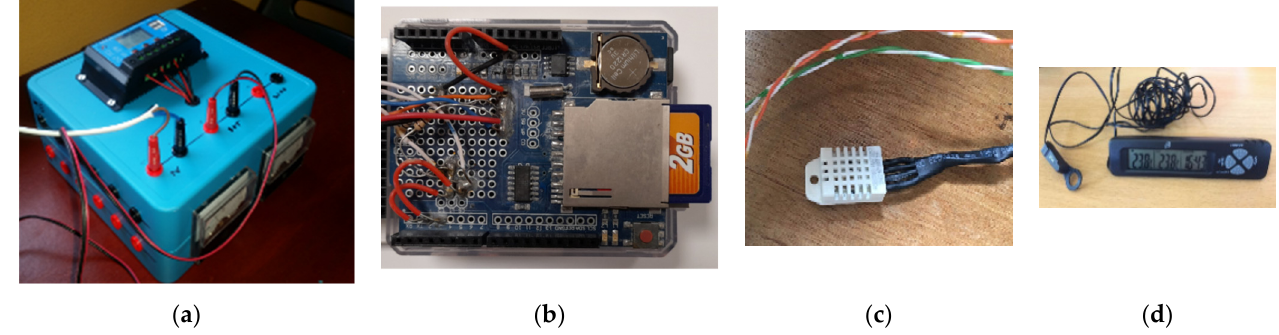
Figure 4. ( a ) Solar charge controller; ( b ) Arduino system; ( c ) Temperature and relative humidity sensor; ( d ) Temperature display. Weight was measured using a Nahita Blue 5162 and a portable Kern EMB 200-3 scales.